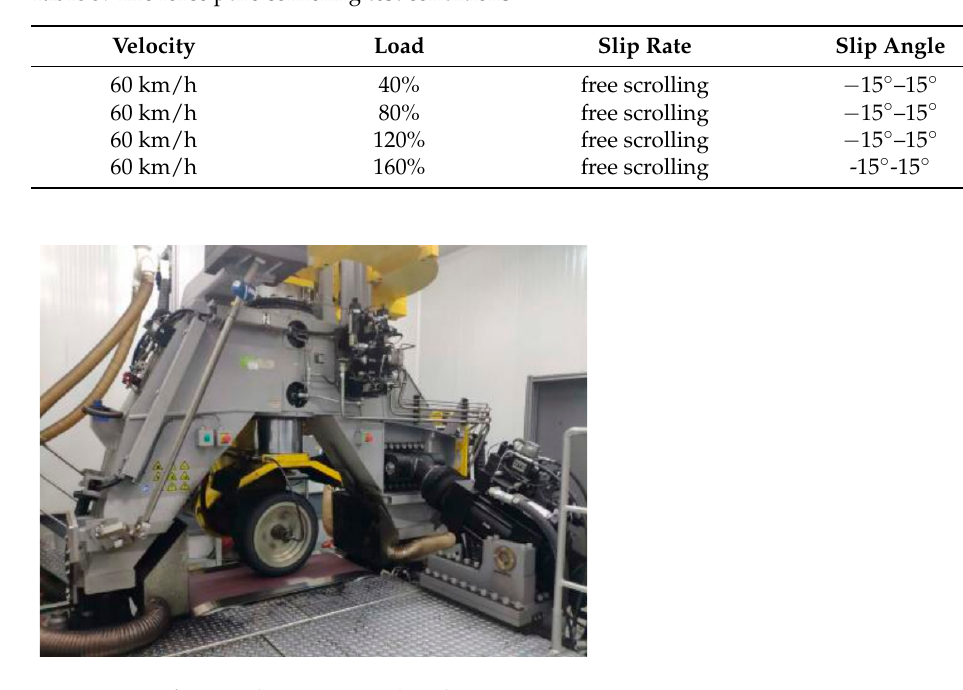
Figure 3. Tire force and moment test bench. Table 2. Tire force pure longitudinal slip test conditions.